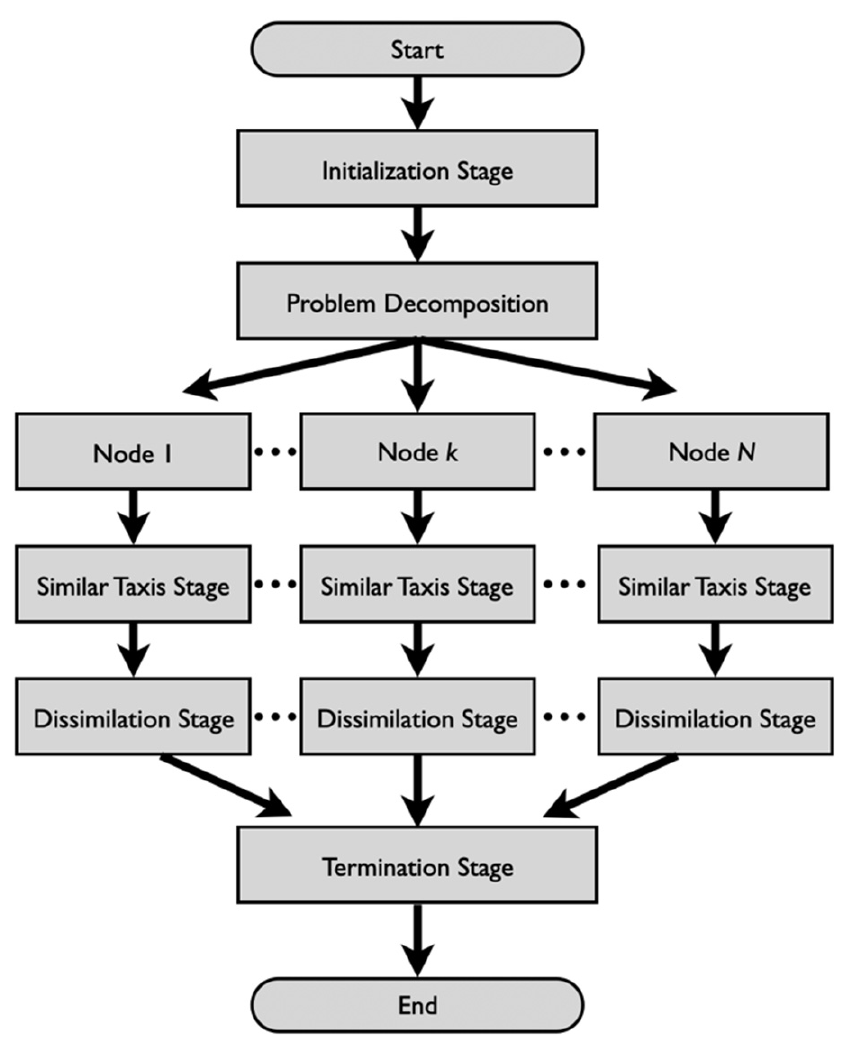
Figure 1. General flow chart of the parallel algorithm for synchronous and asynchronous versions of the PMEC algorithm.